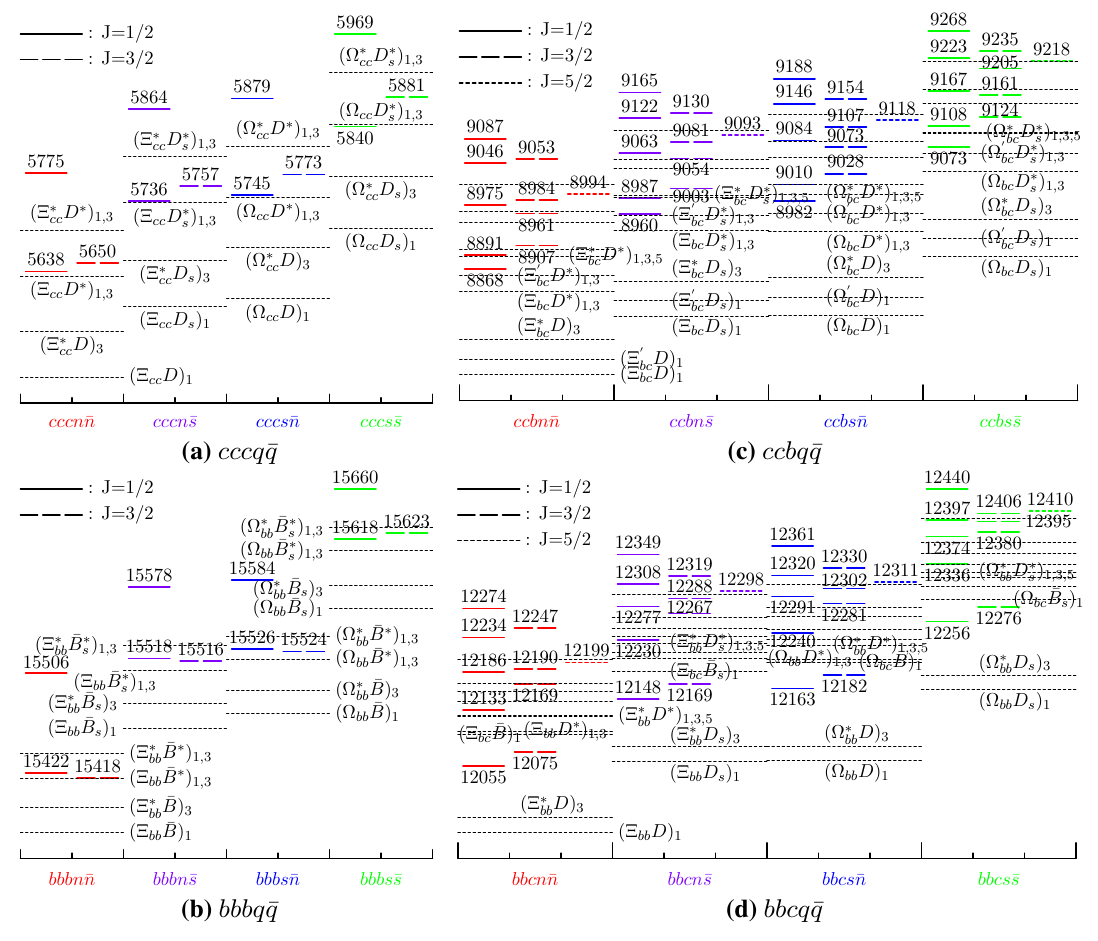
Fig. 1 Rough positions for the obtained triply heavy pentaquarks